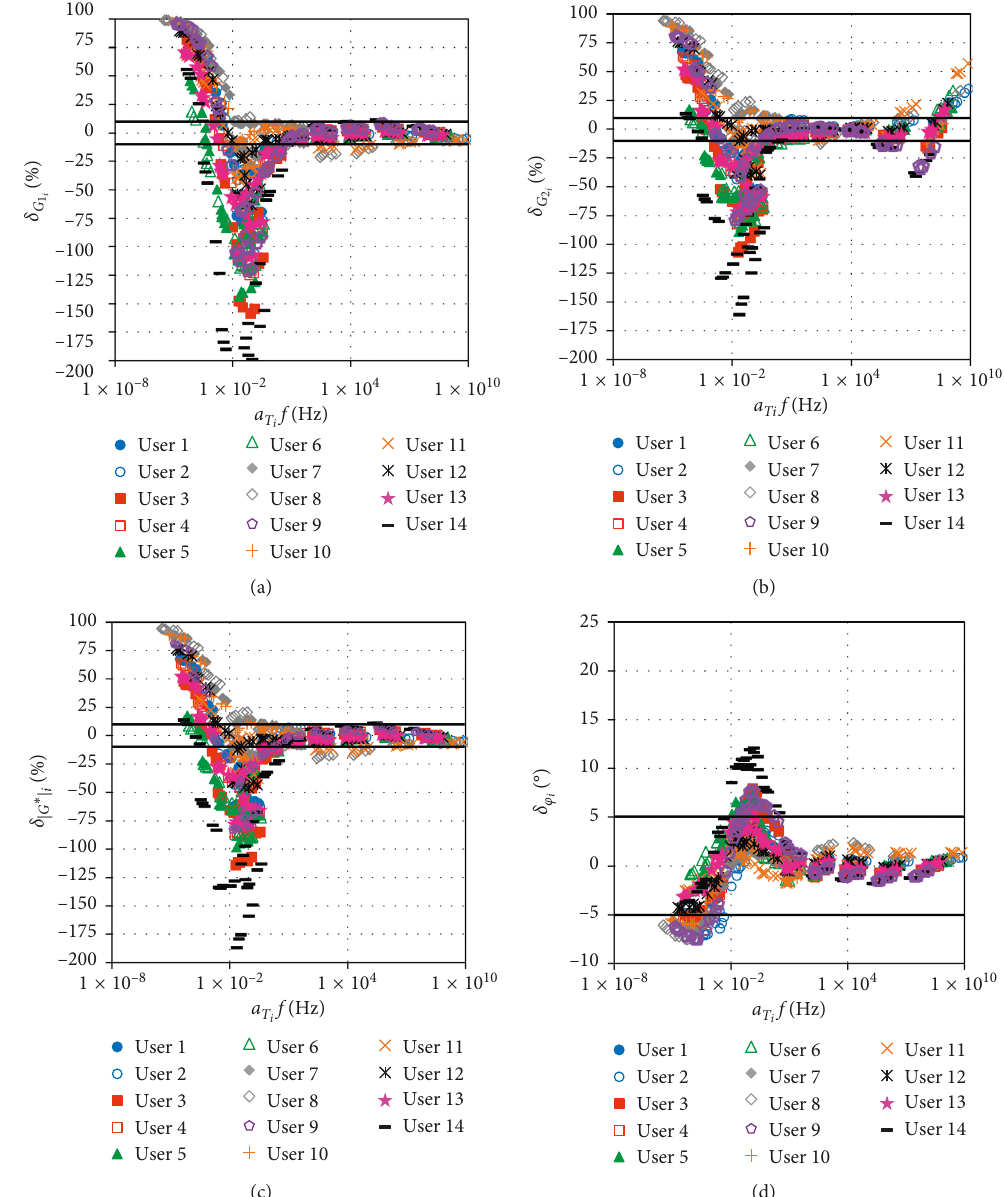
° C): relative errors for G ref (cid:31) 10.00